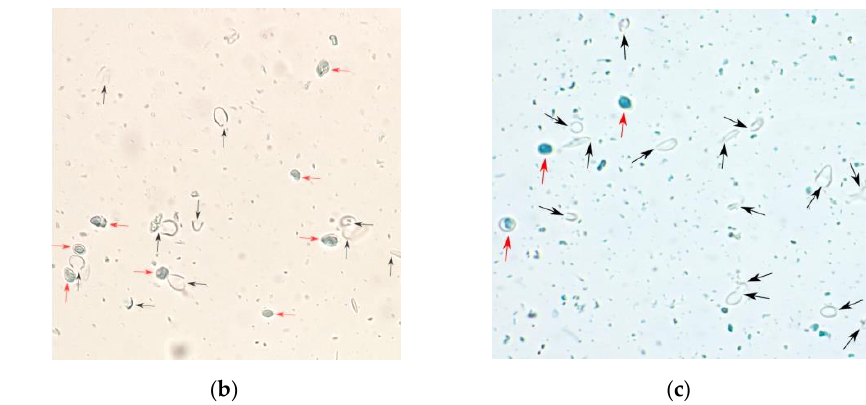
Figure 4. The degree of cell rupture. Three representative samples with a yeast/glass bead ratio of 1:2 at different vortexing cycles (1×, 2×, and 3×) and yeast concentrations (5%, 10%, and 15%) are shown: black arrows indicatethe broken cells with irregular cell walls and red arrows show dead cells stained inside with methylene blue. No living cells were present (400× magnification). ( a ) 15% yeast suspension; 1:2 yeast/ glass bead ratio; 1× vortexing cycle (15.1%). ( b ) 10% yeast suspension; 1:2 yeast/glass beads ratio; 2× vortexing cycles (41.6%). ( c ) 5% yeast suspension; 1:2 yeast/glass beads ratio; 3× vortexing cycles (99.8%).